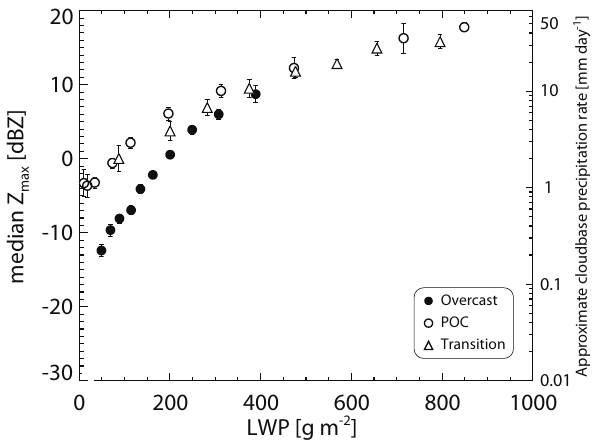
Fig.13. Mediancolumnmaximumreflectivity Z max forallsamplesonwhichtheWCLdetectedcloudsabove, Fig. 13. Median column maximum reflectivity Z max for all samples binned as a function of LWP in the overcast (solid circles), POC (open circles), and transition (open triangle) on which the WCL detected clouds above, binned as a function of regions. All data from the two RF06 subcloud legs SC1 and SC2 are used. The right axis denotes the approx- LWP in the overcast (solid circles), POC (open circles), and transi- imate cloudbase precipitation rate corresponding to Z max constructed using the Z – R relationship discussed in tion (open triangle) regions. All data from the two RF06 subcloud Sect. 2.3. Error bars show approximate 95% confidence limits on plotted means. legs SC1 and SC2 are used. The right axis denotes the approximate cloudbase precipitation rate corresponding to Z max constructed us- ing the Z - R relationship discussed in Sect. 2.3. Error bars show approximate 95% confidence limits on plotted